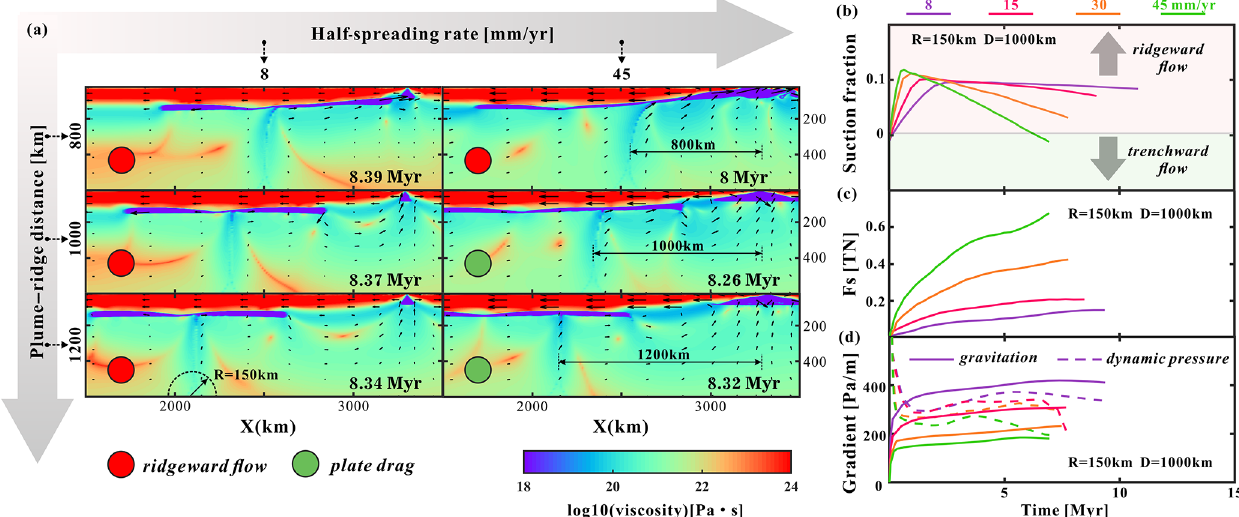
Figure 9. Model results influenced by different half-spreading rates. (a) Effect of half-spreading rate and plume–ridge distance on ridgeward vs plate-drag. Viscosity snapshots are shown (models M7–M9, M82–M84; Table S1). The fast-spreading ridge promotes the dragging of plume material near the ridge. Models with green circles represent plate-drag plume flow, and ridgeward plume flow is represented in red. (b) Dynamic evolutions of ridgeward and plate-drag plume flow, revealed by defined ridge-spreading fraction (Eq. 14). (c) Shear force ( F s ) between moving-plate and plume material under different spreading rates. (d) Pressure gradient between plume head and ridge center in different half-spreading rate models. The solid and dashed lines are the plume gravitation and dynamic-pressure gradient, respectively. R and D stand for half of the plume radius and plume–ridge